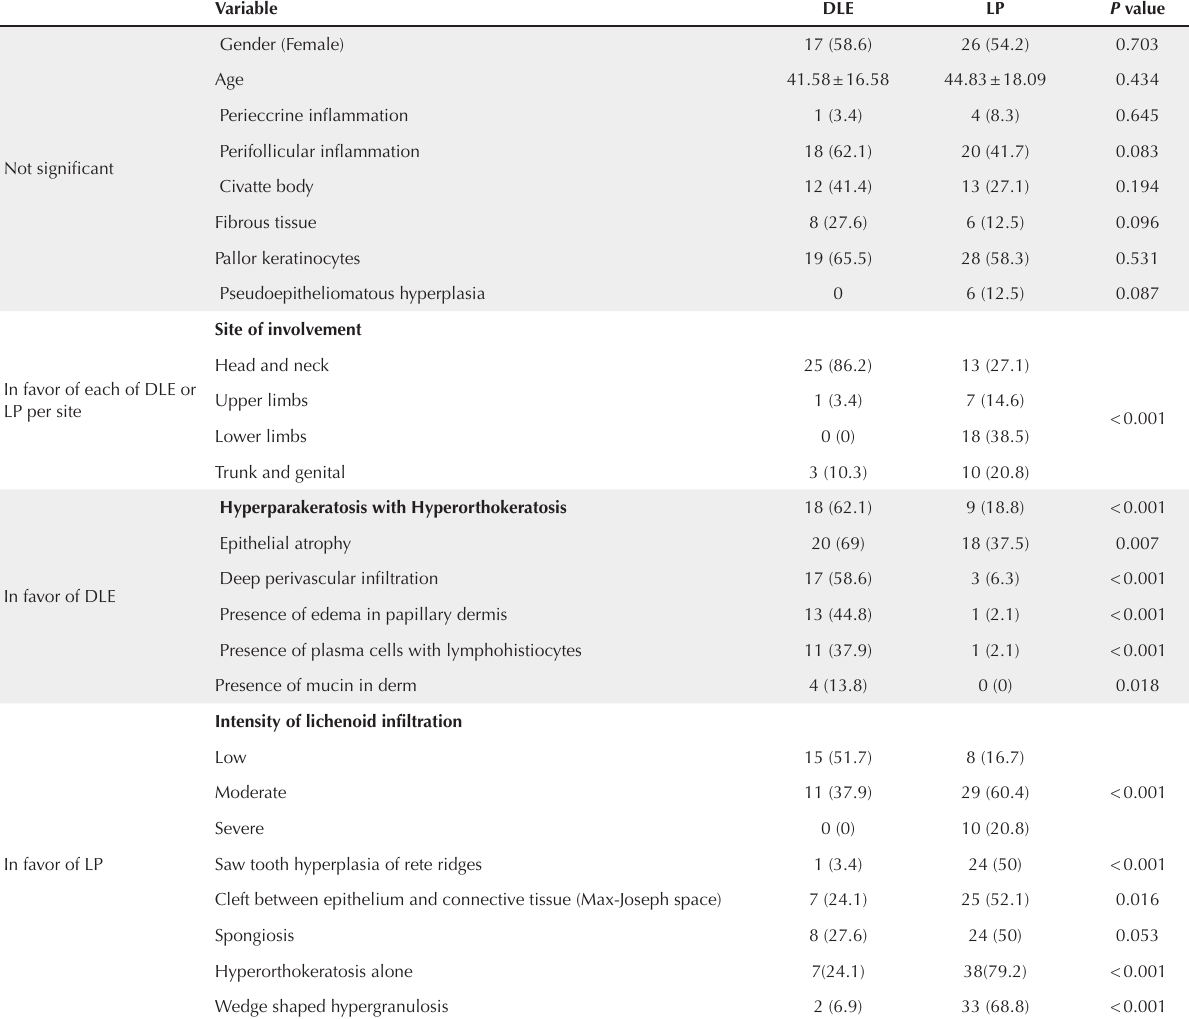
Table 1. Comparison of characteristics of DLE and LP Variable DLE LP P value Gender (Female)